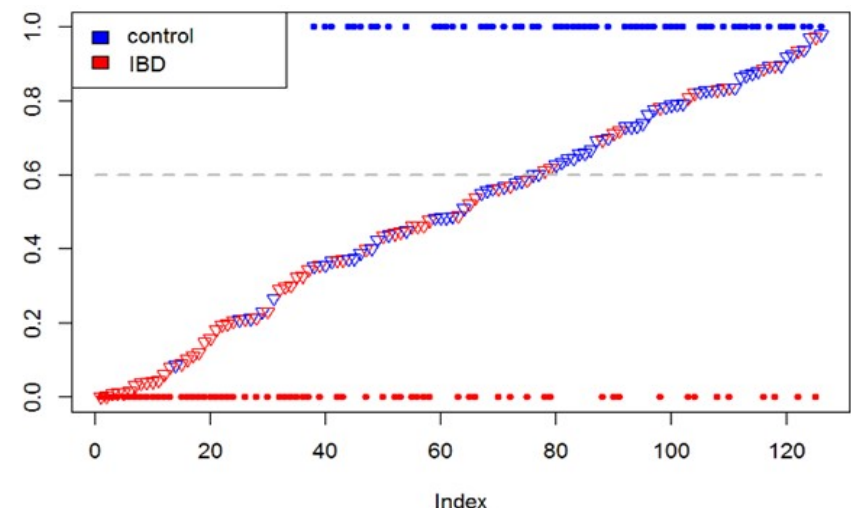
Figure 4. Prediction of inflammatory bowel disease based on leave-one-out cross-validation. Dashed line indicates a cut-off value of 0.6. Y-axis depicts the predicted probabilities of being healthy (so no IBD) for all samples. On the X-axis, the samples are depicted, sorted by predicted probability of IBD, represented by triangles. Dots indicate the known sample classification (healthy control, at y = 1 and blue; IBD, at y = 0 and red).